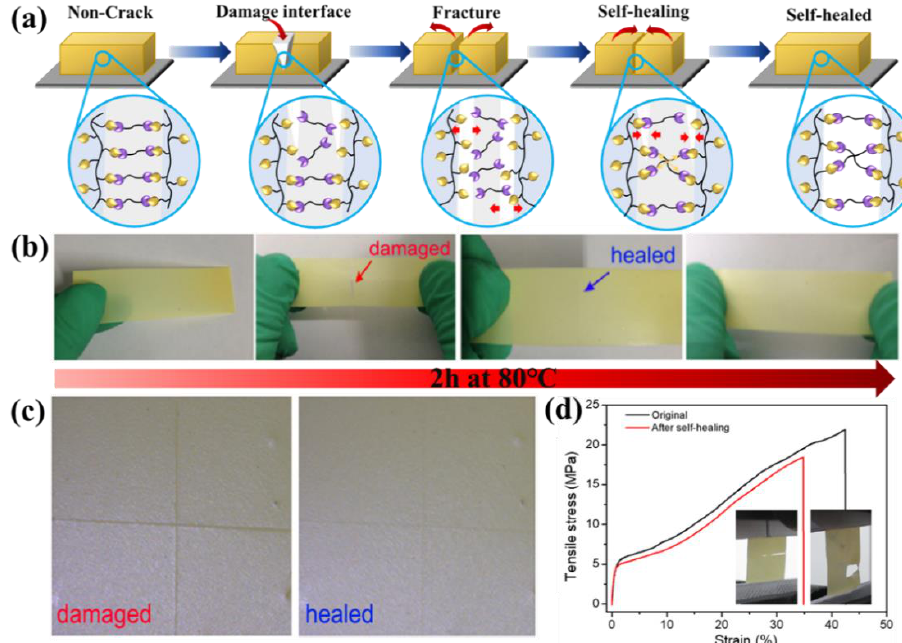
Figure 4. The mechanical self-healing properties of the SHP electrolyte membrane (after 2 h under 80 °C). ( a ) Schematic illustration of the self-healing process with DA reaction. ( b ) Demonstration of the healing process for the SHP electrolyte membranes (the thickness of the membranes is about 25 μm). ( c ) Optical microscopic images of a damaged sample (left) and fracture healing (right) for the damaged sample. ( d ) Tensile measurements of the SHP electrolyte membrane, and the healed sample (inset: snapshots of SHP membranes after tensile measurements).